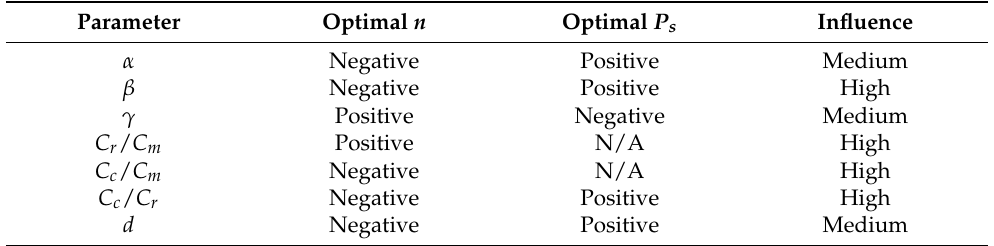
Table 4. Summary of effects of model parameters and cost ratios on determination of the optimal n and P s value.